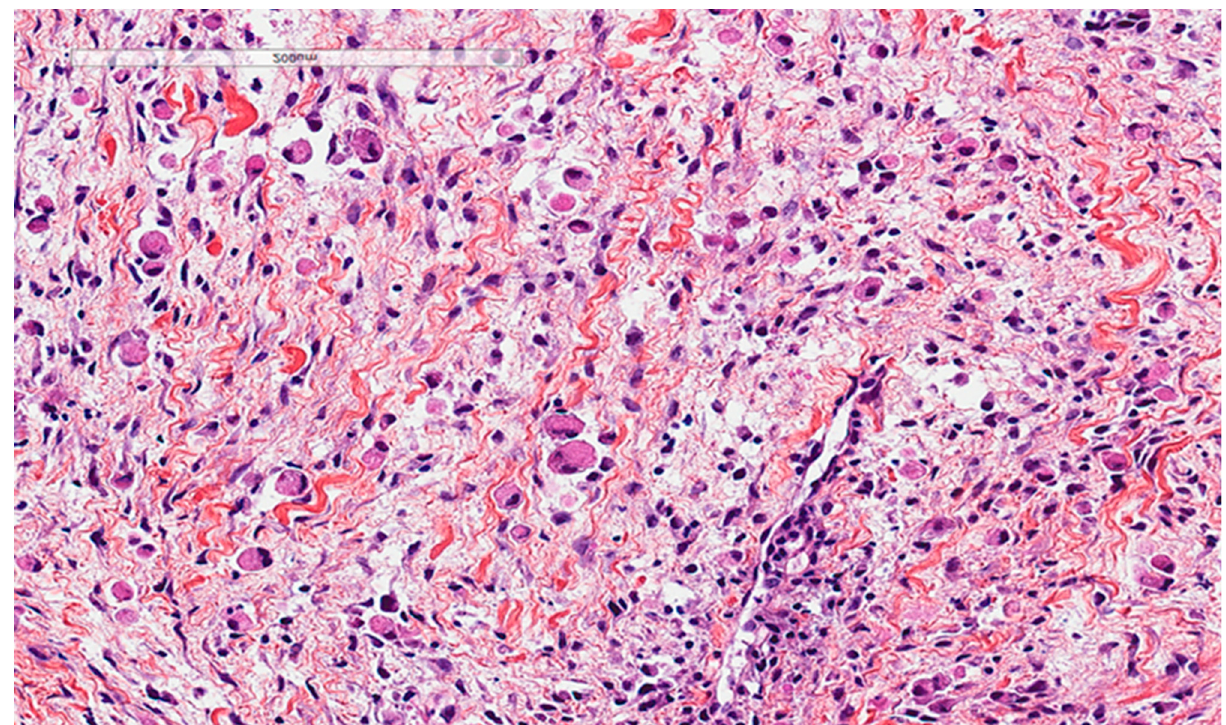
Figure 4. Rhabdomyoma cells also show an abundant eosinophilic cytoplasm. This lesion presented as a vocal cord polyp in a 67-year-old male patient.